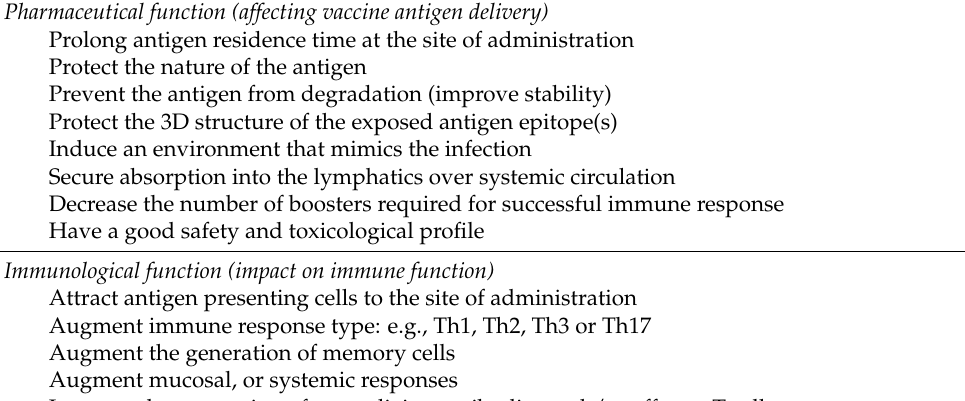
Table 1. Pharmaceutical and Immunological Functions of vaccine